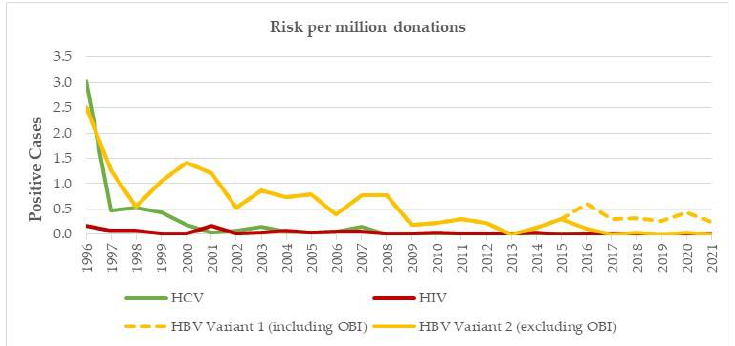
Figure 5. Theoretical estimated RR for HCV, HIV and HBV from 1996 to 2021. HBV has two models after 2015, one with the OBI cases and one without OBI cases. Table 2. Theoretical calculated inverse of the RR for HCV, HIV and HBV from 1996 to 2021. HBV (Variant 1, HBV (Variant 2, Year HCV [1/RR] HIV [1/RR]